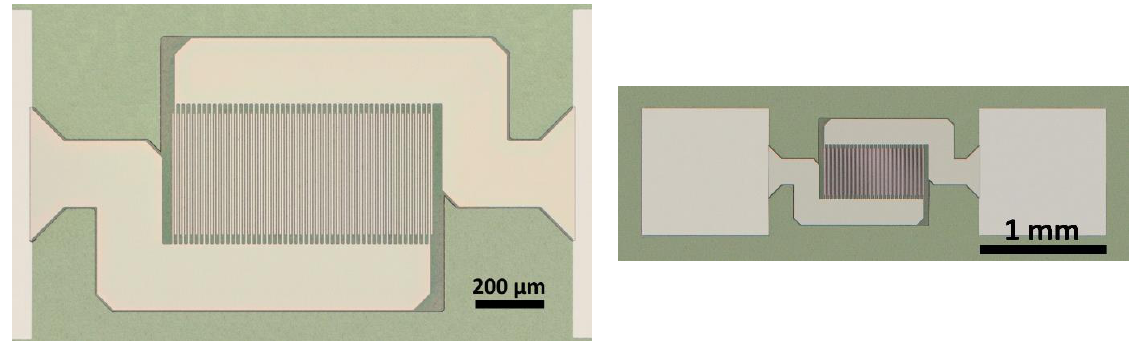
Figure 1. Images of the IDE electrode geometry.